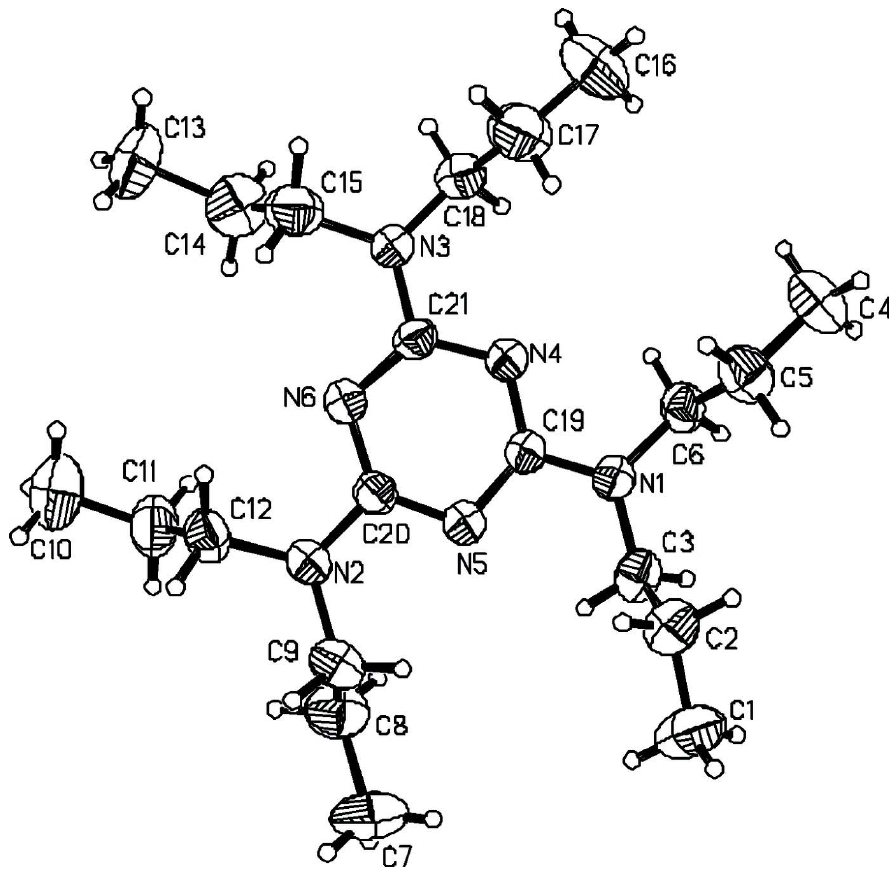
The structure of the title compound showing 30% probability displacement ellipsoids and the atom-numbering